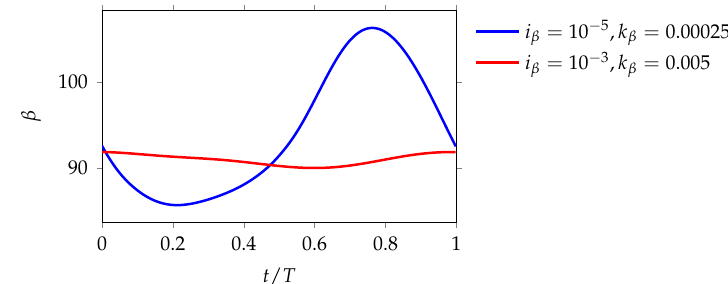
Figure 14. Flap deflection in one time period of lift cycle.